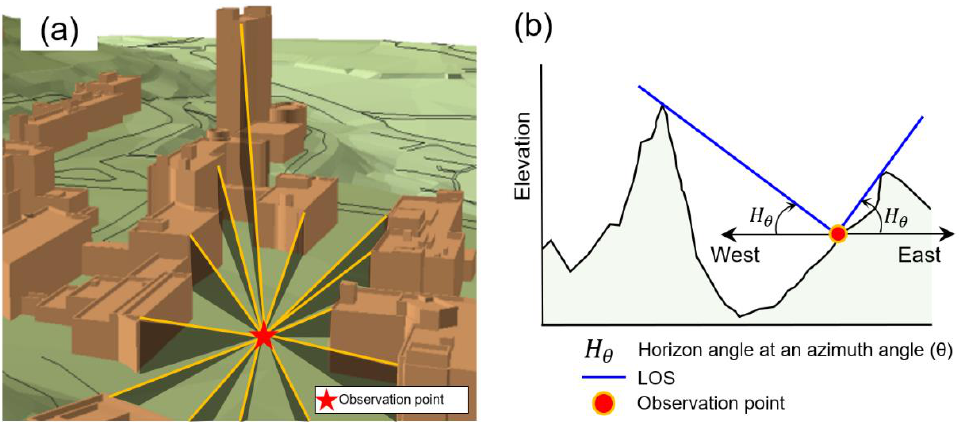
Figure 2. Diagrams of hemispherical viewshed analysis. ( a ) Perspective view of 3D models showing the horizon angle between the survey point and shading obstructions along the LOS at each azimuth angle. ( b ) Section view of the terrain showing the horizon angle between the survey point and terrains at the east and west azimuth directions.